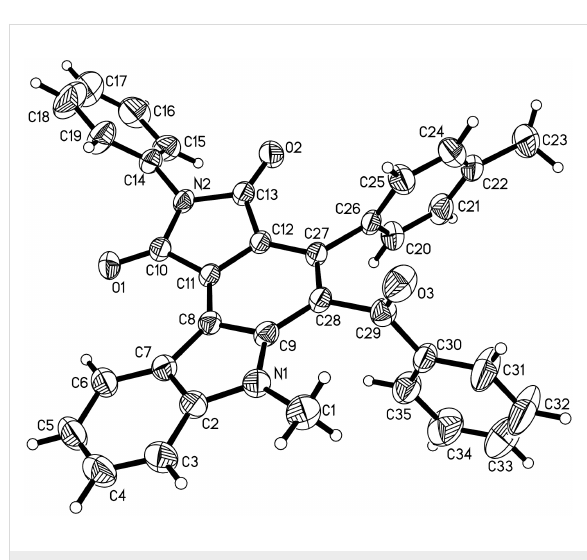
Figure 4: Single crystal structure of the isomer 4g .